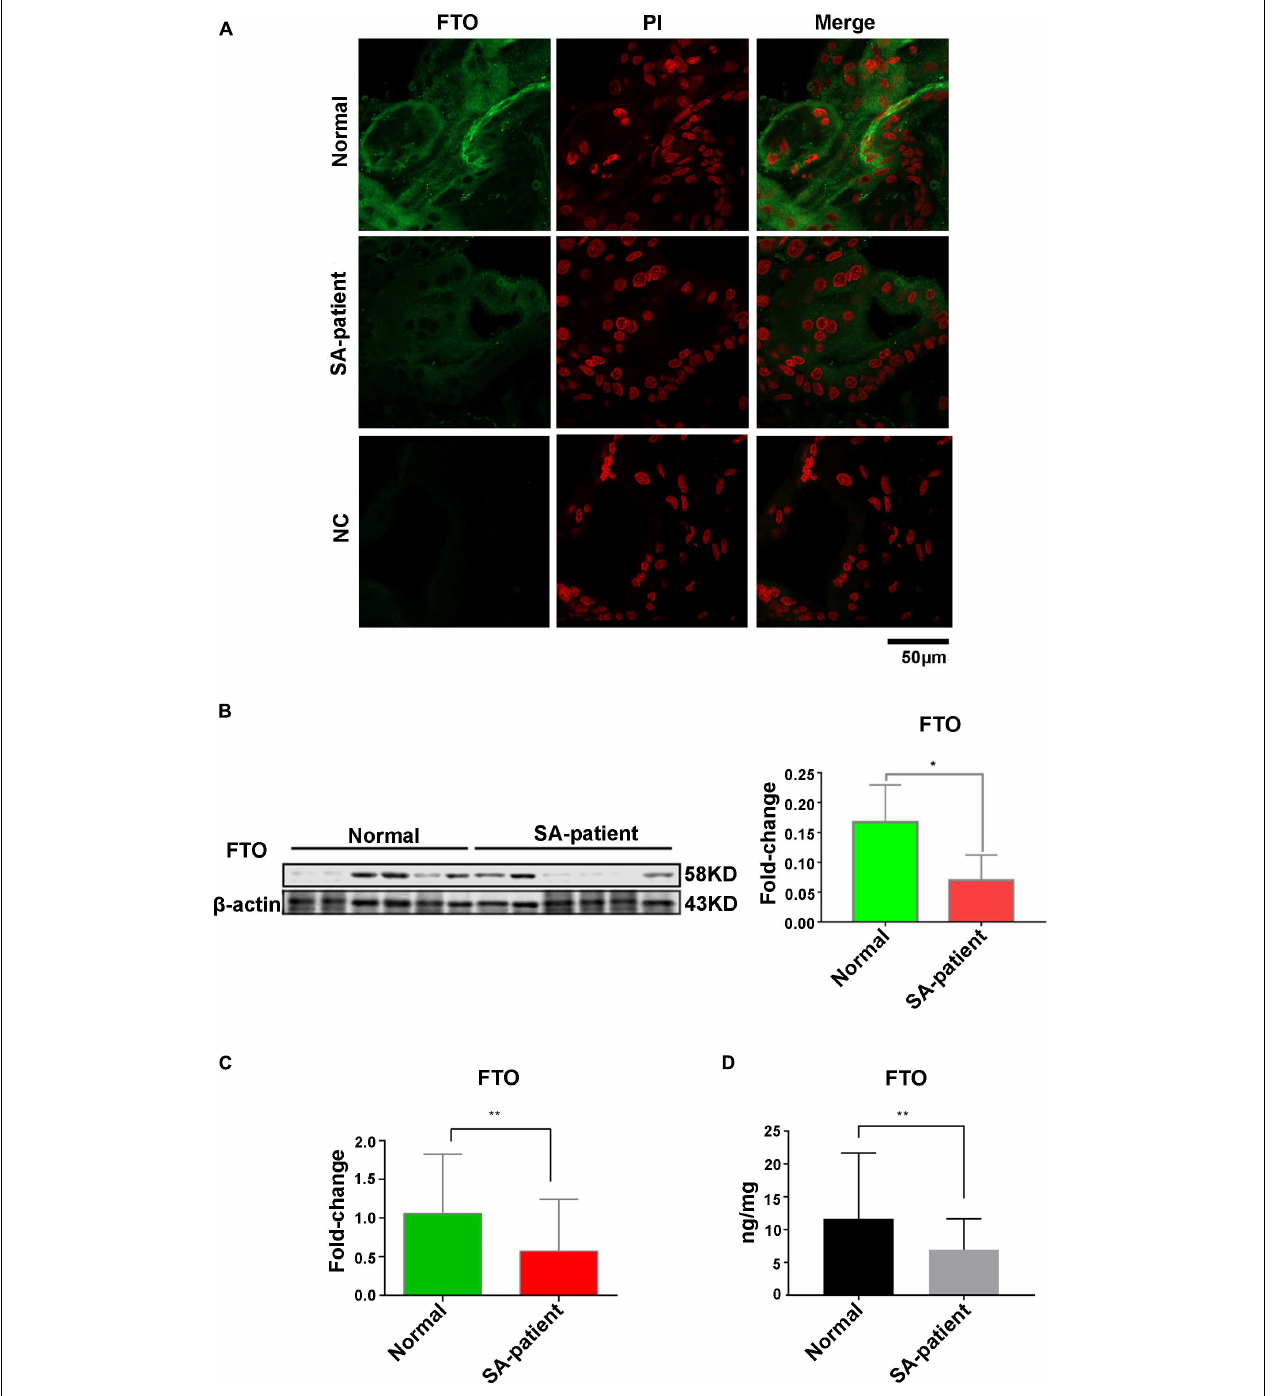
FIGURE 2 | (A) Representative immunofluorescence images of chorionic villi showing in situ expression of FTO in both groups. Green, FTO; Red, PI counterstained nuclei. Normal n = 3; Patient n = 3; NC, negative control n = 3. (B) Immunoblot showing expression level of FTO protein in the villi of two groups (Normal n = 6; Patient n = 6), * P <0.05. (C) The expression level of FTO mRNA in villi of two groups (Normal n = 30; Patient n = 67), ** P <0.01. (D) The expression level of FTO in the villi of two groups as detected by ELISA (Normal n = 28; Patient n = 48), ** P <0.01.